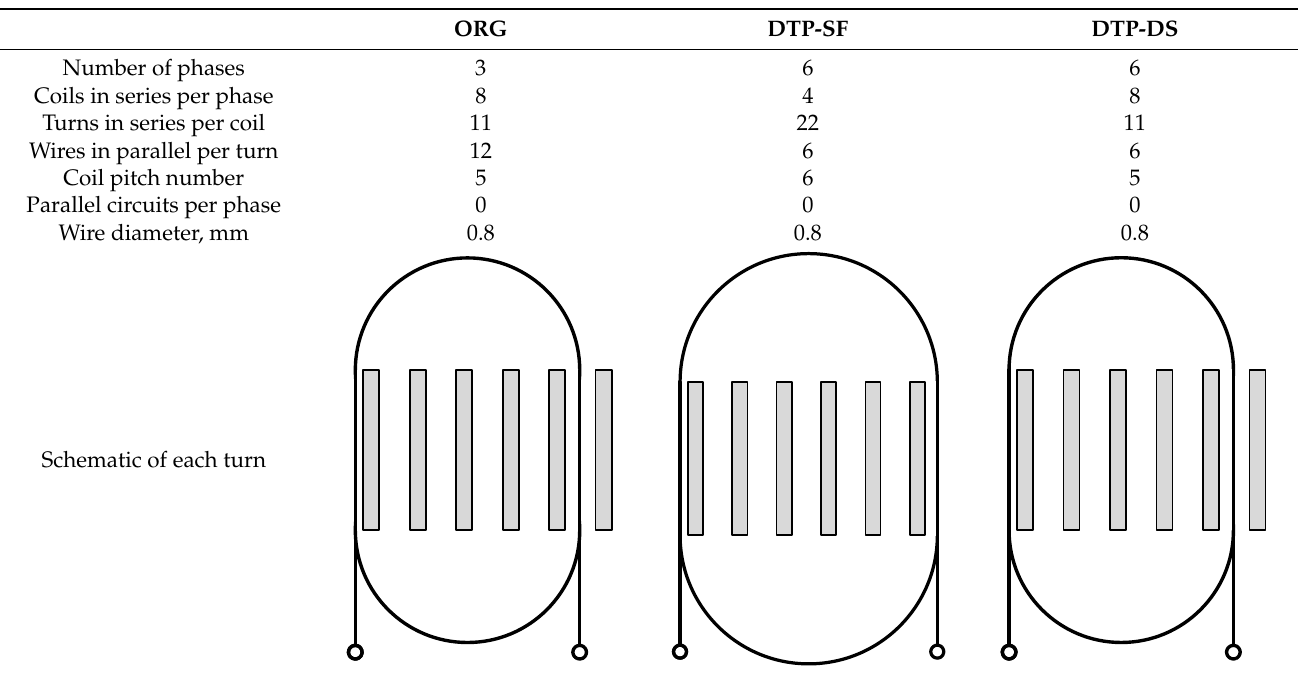
Table 2. Specifications of different winding